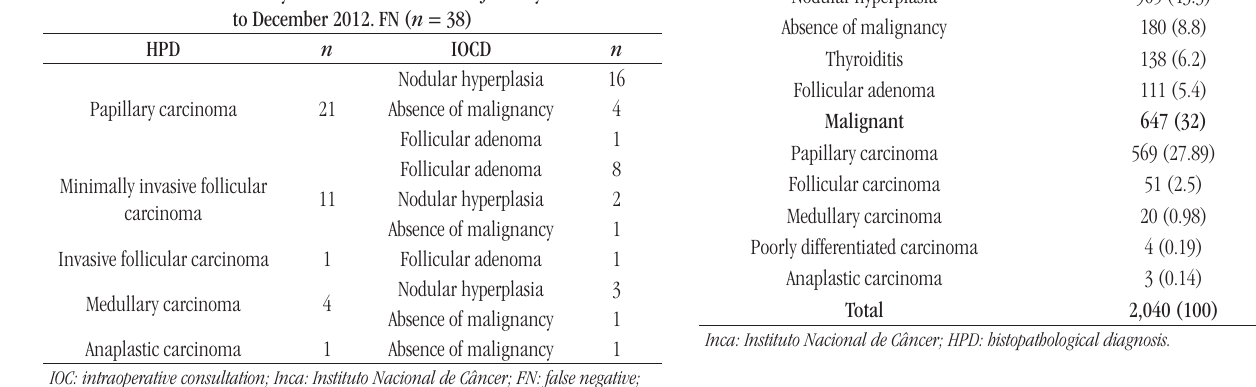
taBLE 2 – IOC of thyroid lesions at Inca from January 2001